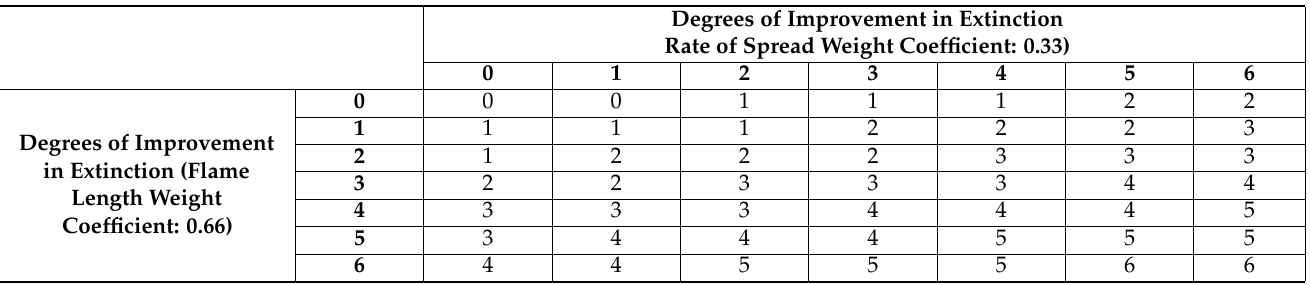
Table 6. Final reclassification matrix of degrees of improvement in extinction, considering flame length and rate of spread. Degrees of Improvement in Extinction Rate of Spread Weight Coefficient: 0.33) 0